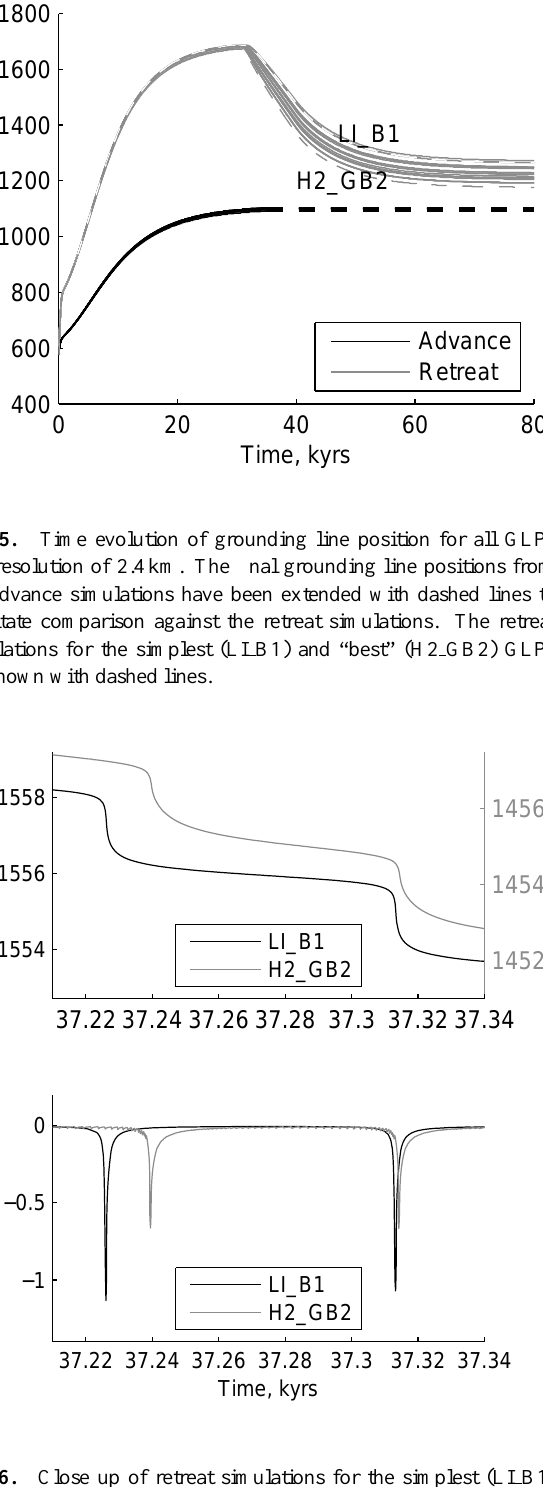
Fig. 6. Close up of retreat simulations for the simplest (LI B1) and “best” (H2 GB2) GLPs run at 2.4km resolution. The top panel shows grounding line position with time (the y-axes are offset but with identical scaling to facilitate comparison) and the lower panel shows grounding line velocity with time (i.e. velocity of the ground- ing line itself, not the velocity of the ice at the grounding line).